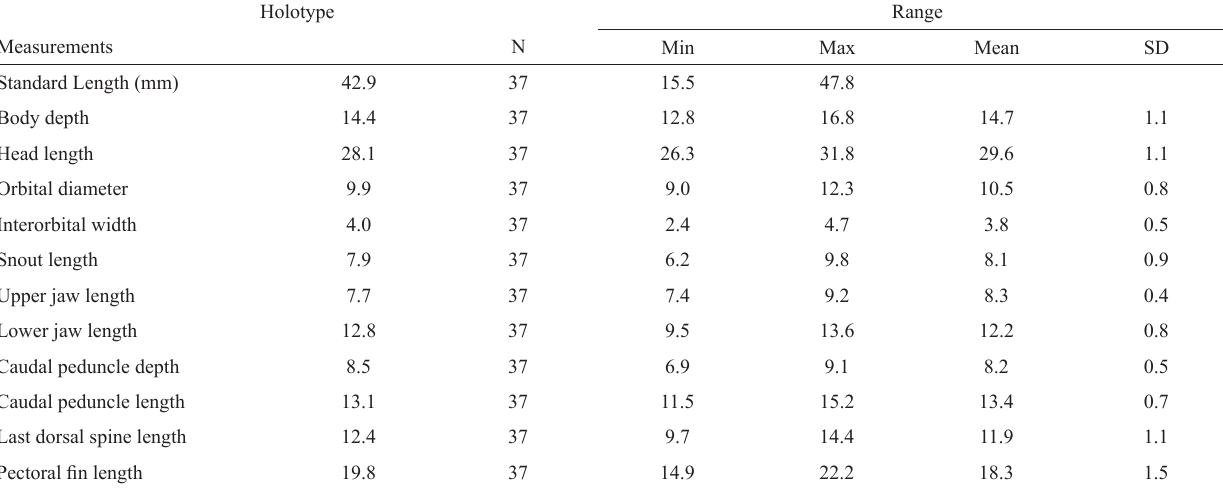
Table 1. Morphometric data of Crenicichla anamiri sepatared for the holotype and remaining specimens examined. SD = Standard deviation; n = number of specimens. Holotype Range